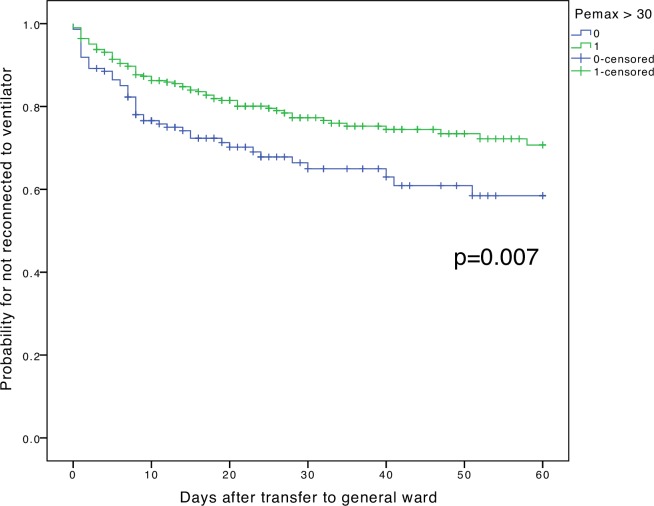
Kaplan-Meier plot for the reinstitution of MV within 30 days, grouped by before-weaning PEmax > 30 cmH2O.